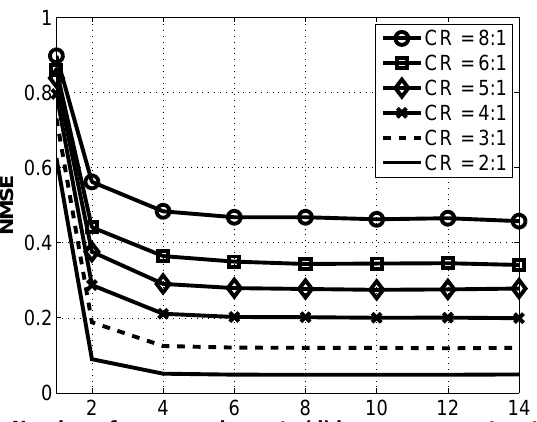
Figure 5. NMSE vs . d for different